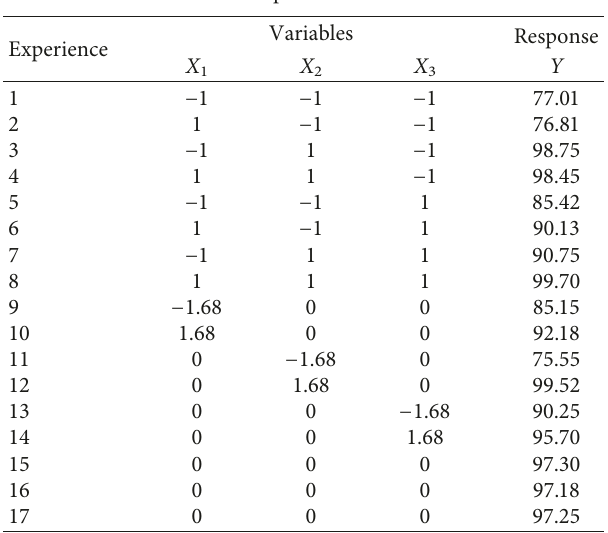
Table 3: Experimental matrix.